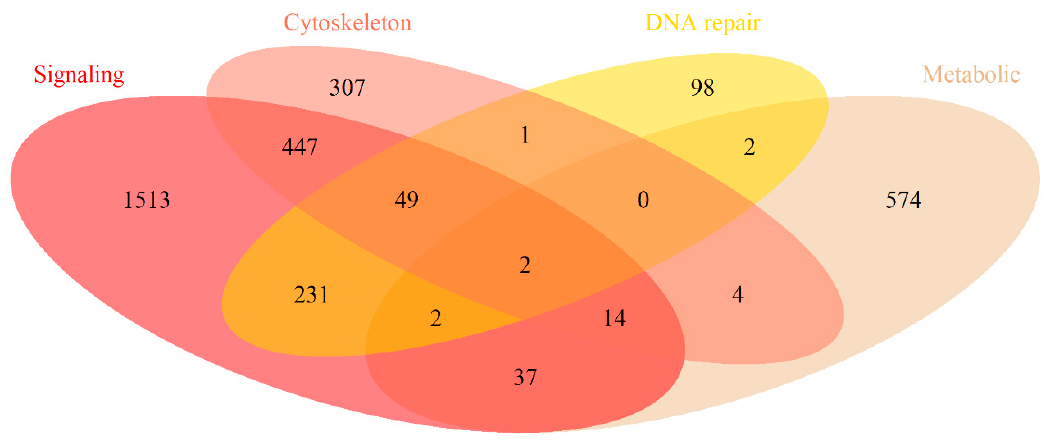
Figure 4. Intersection of gene composition for different functional groups of molecular pathways.